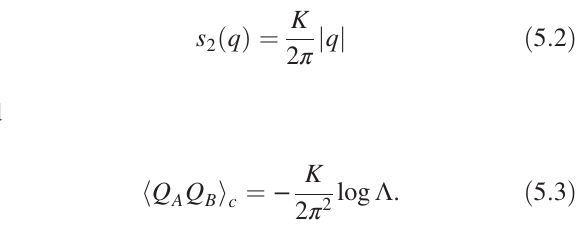
0 . 5 , corresponding to